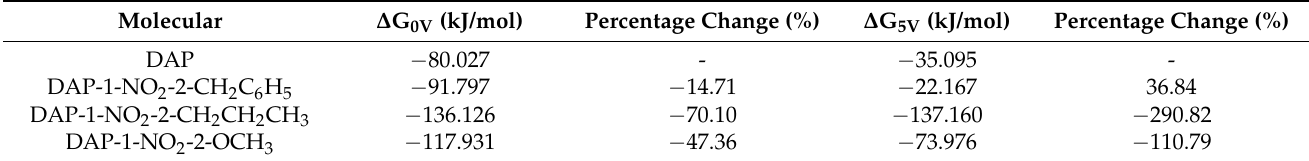
Table 6. Binding free energy of PAE derivatives and percentage change under different applied electric